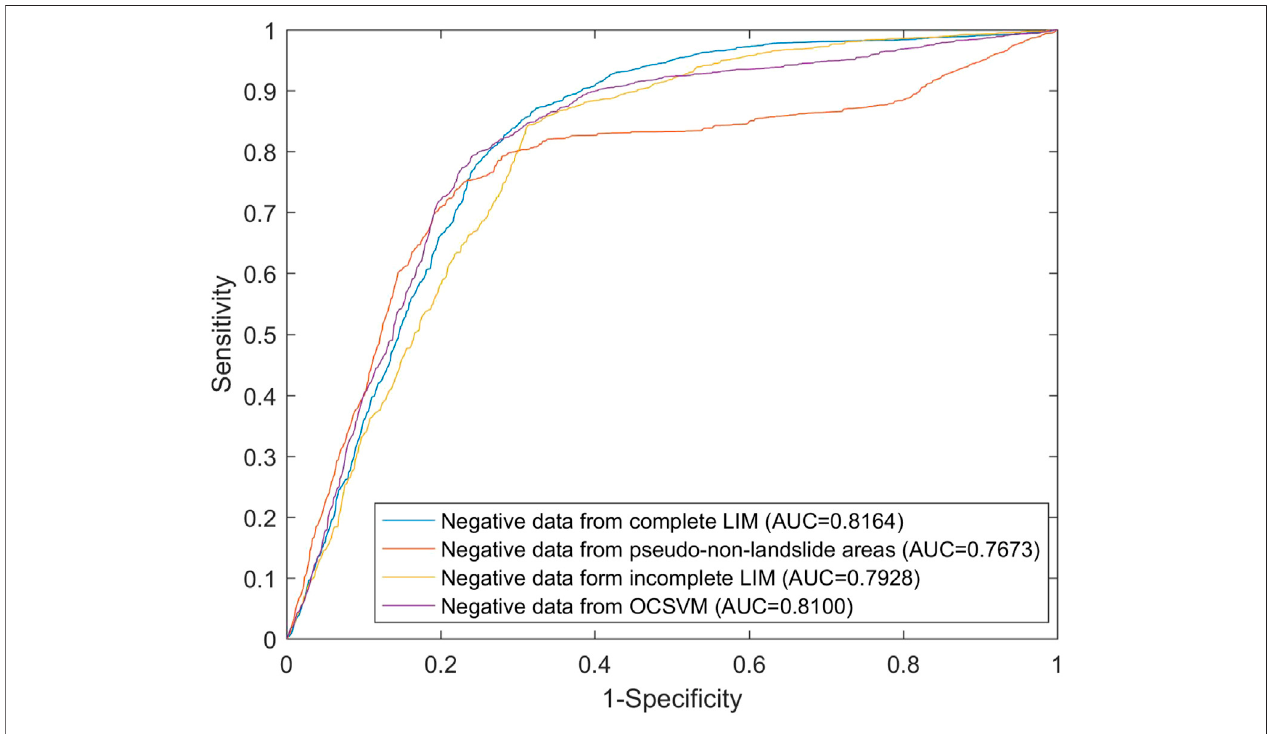
FIGURE 8 | ROC curves of four negative data generation strategies.